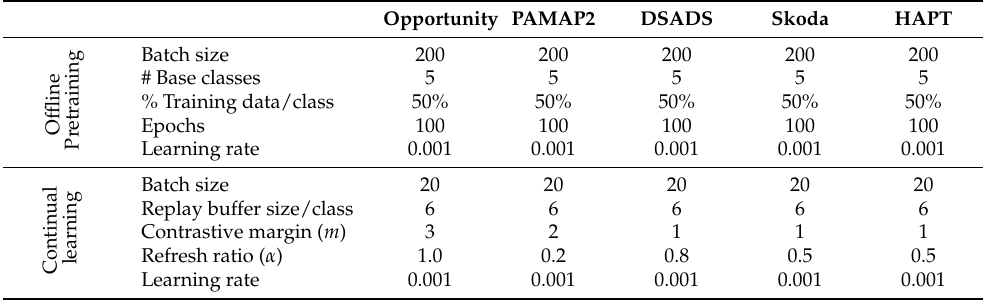
Table 3. Hyperparameter